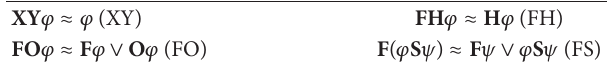
Table 7: Reduction rules for formulae involving adjacent U opera- tors.